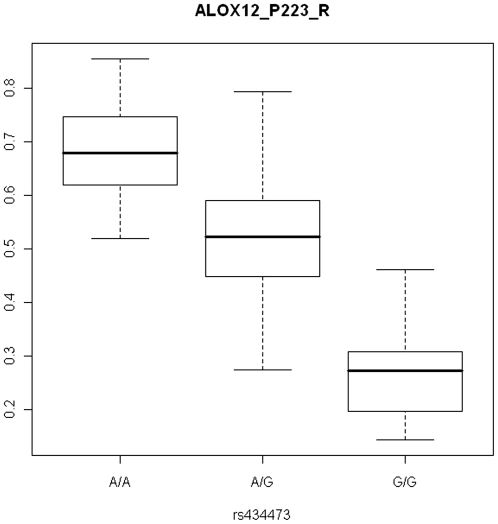
Sample plot of DNA methylation levels at probe ALOX12_P223_R by genotype of SNP rs434473.